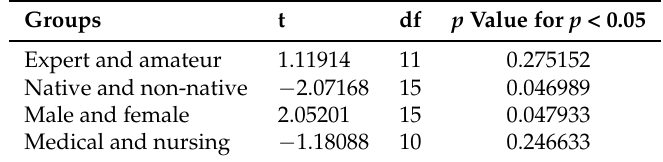
Table 6. Two-tailed T-Test analysis on Trial 2 P-score for different groups. Groups t df p Value for p < 0.05